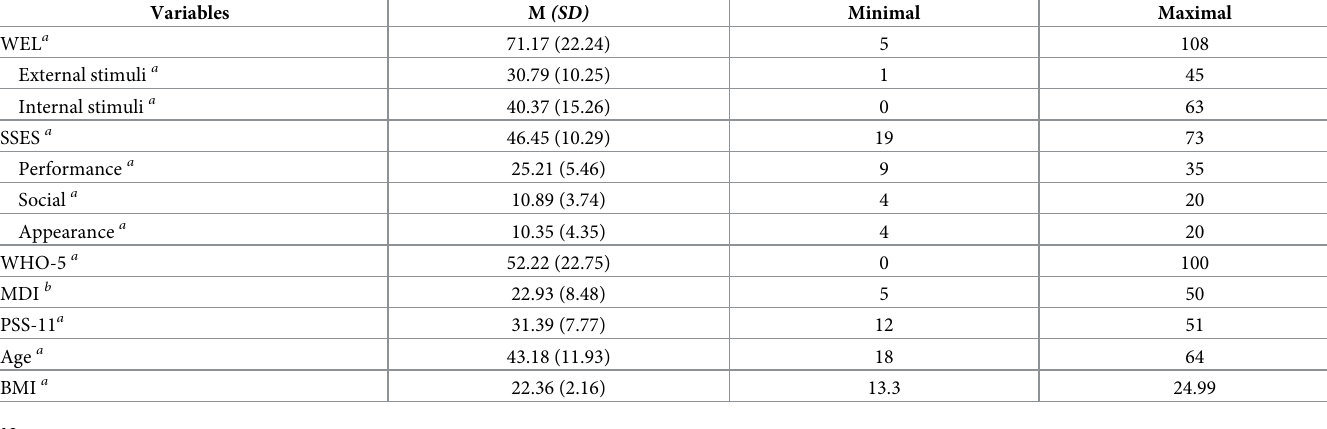
Table 2. Means and standard deviations of the measured variables in a sample of the general French population.